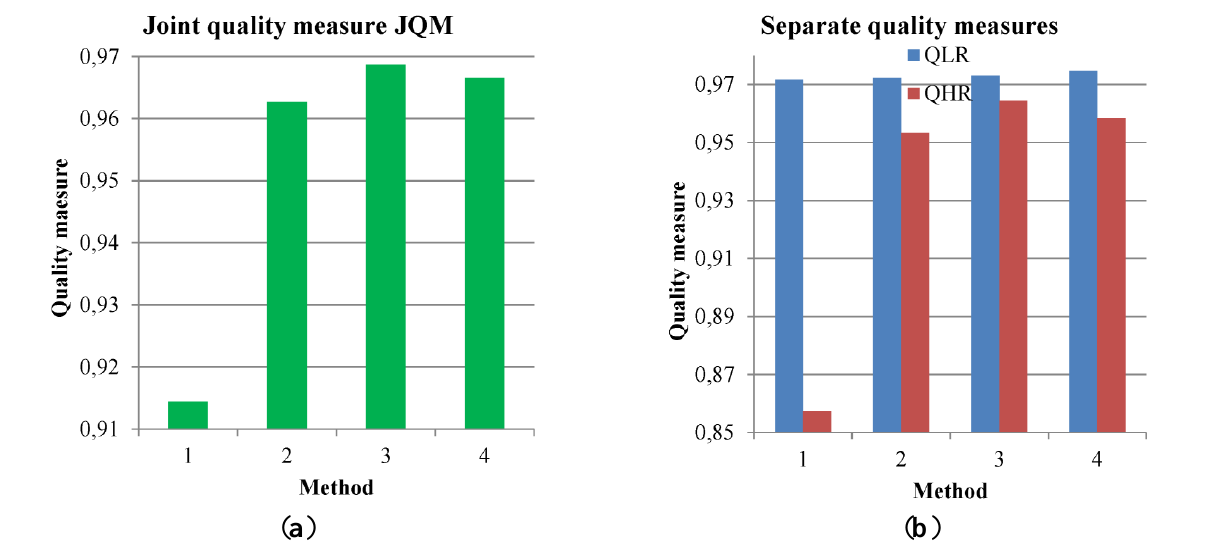
Figure 8. JQM quality assessment of HPFM for different interpolation methods: 1—NN, 2—ZP, 3—BIL, and 4—CUB for WorldView-2 data. ( a ) JQM, ( b ) QLR and QHR.